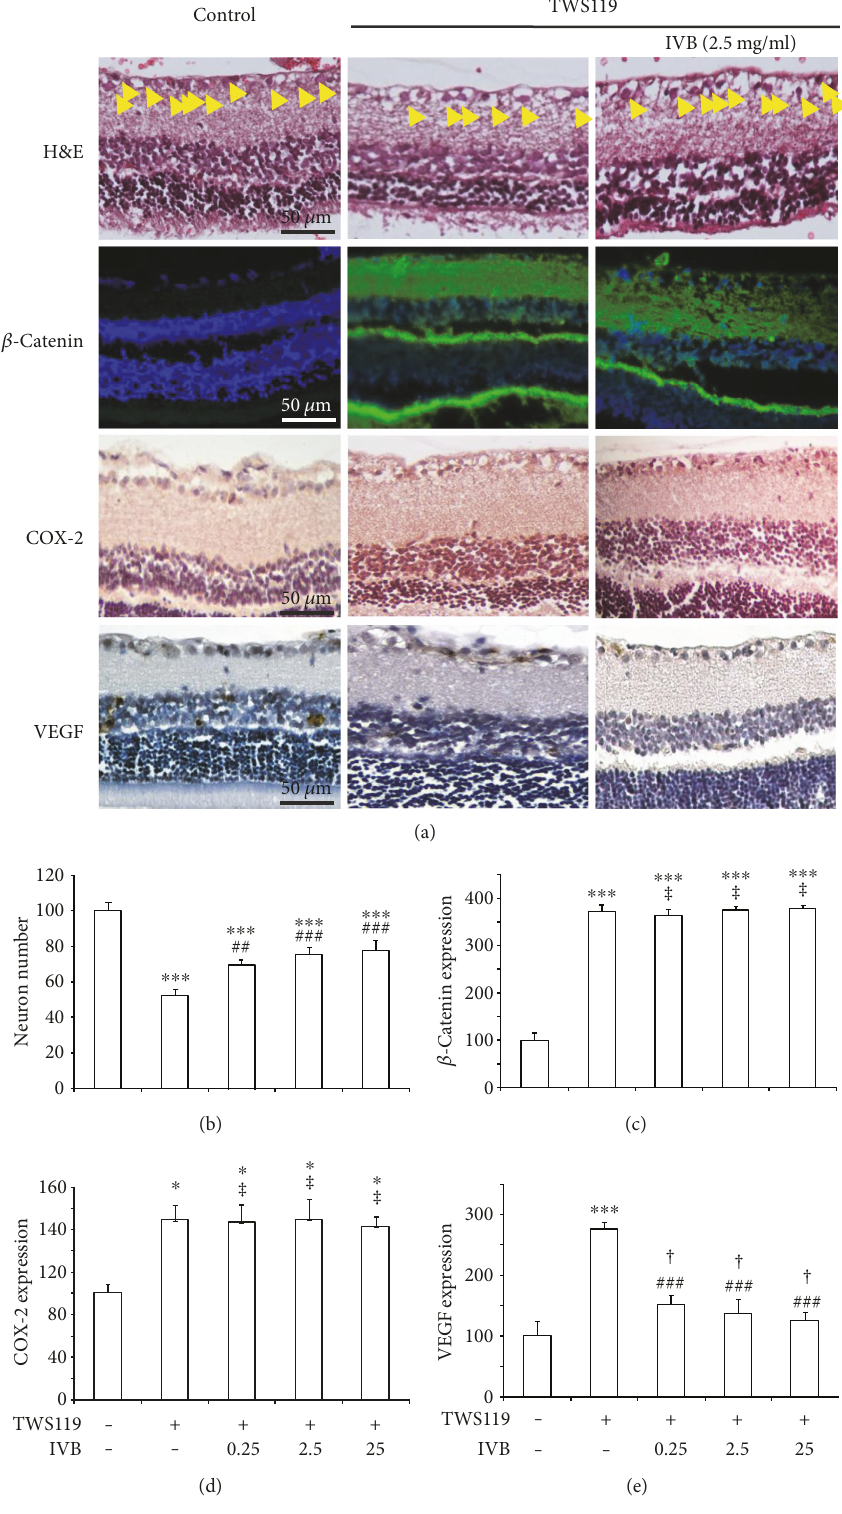
Figure 6: IVB could ameliorate retinopathy caused by TWS119 through reducing VEGF expression (a) Representative images (H&E staining, expression of β -catenin, COX-2, and VEGF) of the rats. (b) Neuron number of RGCs with respect to control (untreated), in TWS119-injected retinas of animals treated with IVB. (c) β -Catenin expression of retinas with respect to control in TWS119-injected retinas of animals treated with IVB. (d) COX-2 expression of retinas with respect to control in TWS119-injected retinas of animals treated with IVB. (e) VEGF expression of retinas with respect to control in TWS119-injected retinas of animals treated with